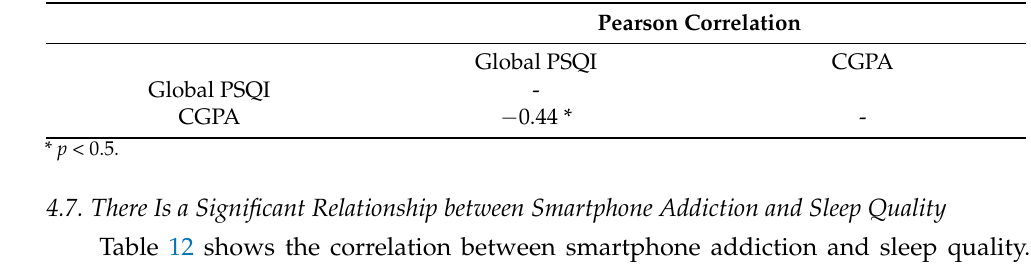
Table 11. Pearson correlation of sleep quality and academic performance.